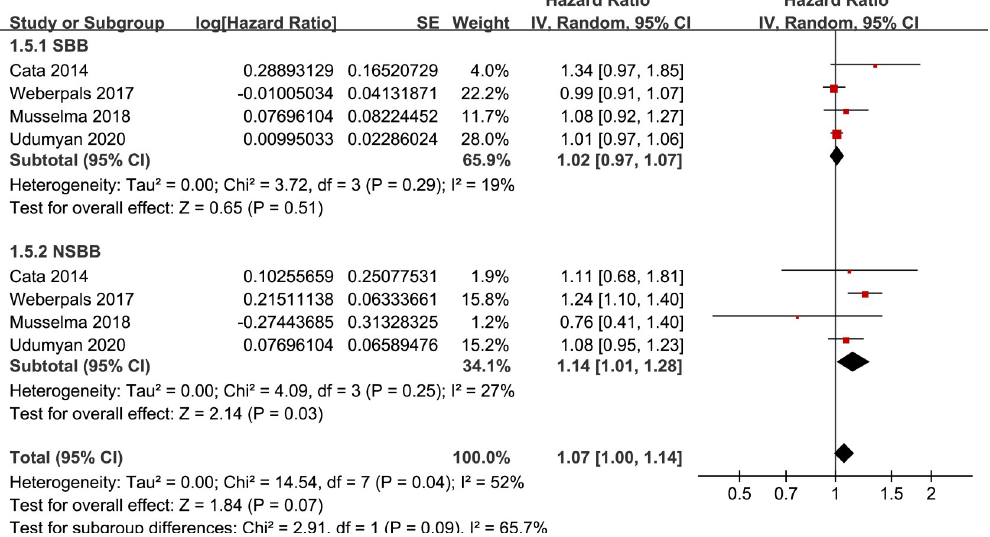
Fig 7. Stratified analyses for the meta-analysis of the association between BB use and OS of lung cancer according to the category of